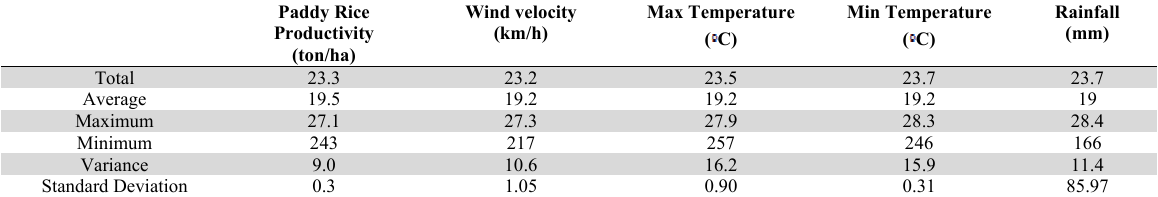
Average Bandung Weather per semester from 2008-2019